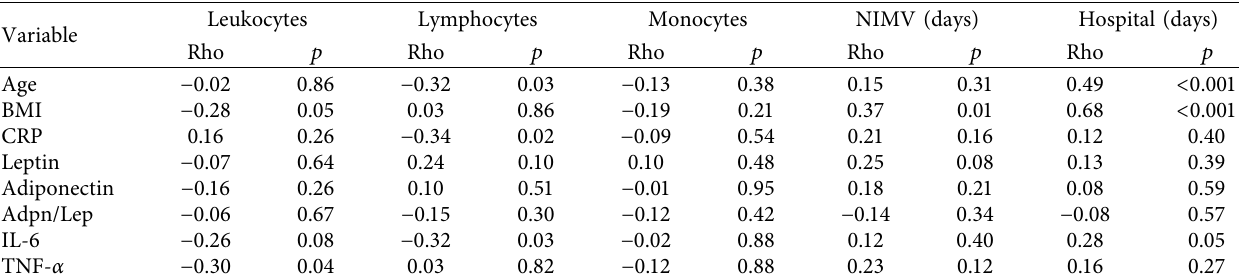
Table 3: Linear association between adipokines and features of patients with COVID-19